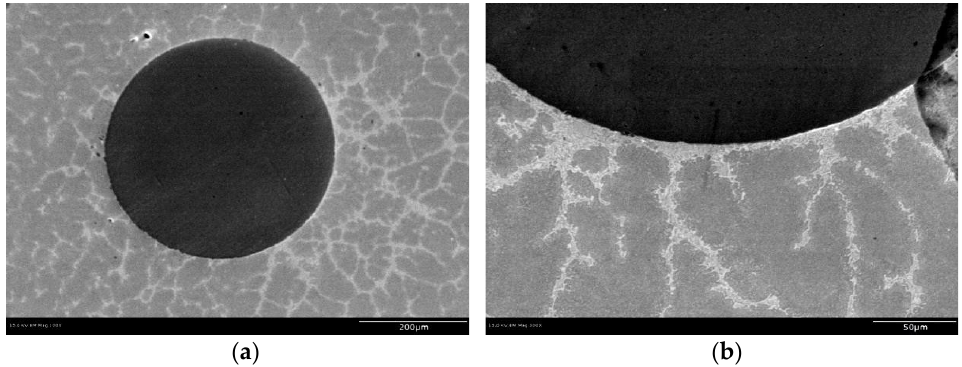
Figure 2. SEM image of Sn-20% Bi with a NiTi reinforcement (d = 500 µm) at ( a ) 300× and at ( b ) 1000× magnification. Reprinted/adapted with permission from Ref. [20]. 2013, Shobhit Misra.